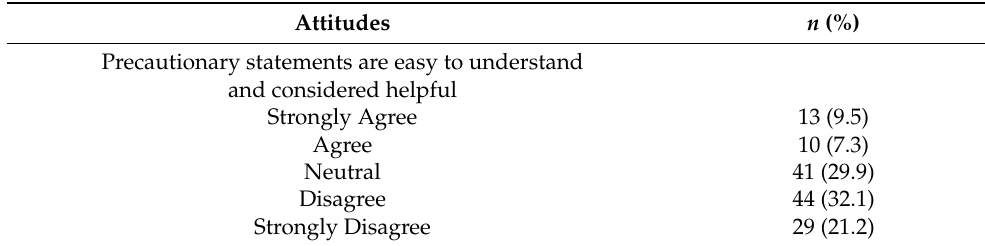
Table 7. Attitudes toward food allergen